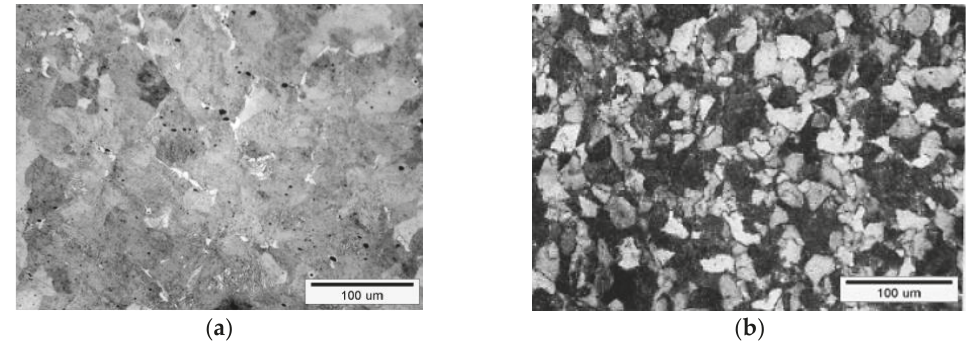
Figure 2. Optical microstructure of the tested steels: ( a ) C70S6; ( b ) 36MnVS4.